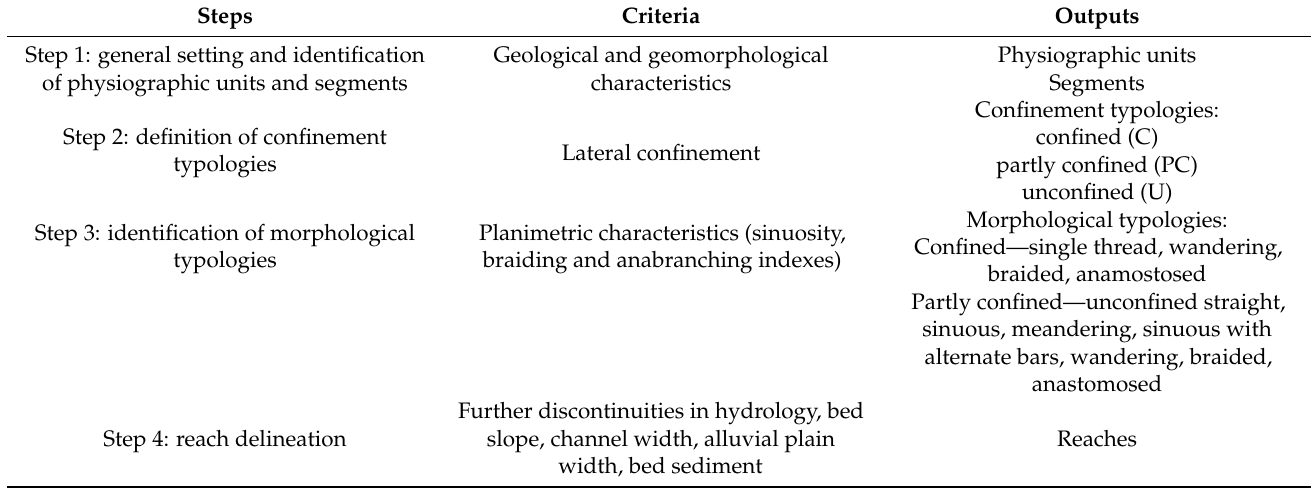
Table 1. Summary of the general setting and segmentation procedure (modified from